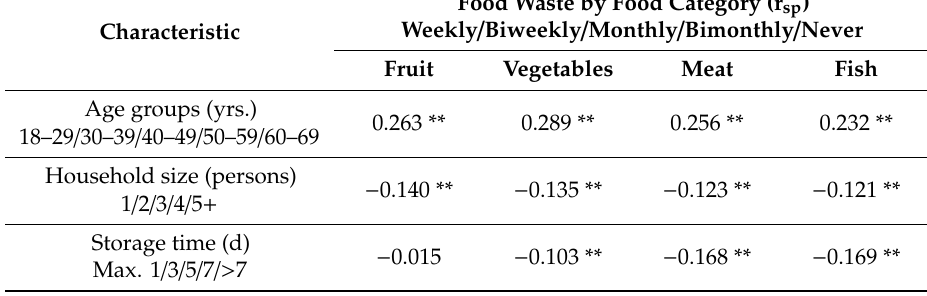
Table 3. Correlations between demographic characteristics or storage time and the rate of food waste for food categories (** = significance r sp at 0.01).